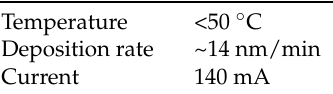
Table 1. Sputtering